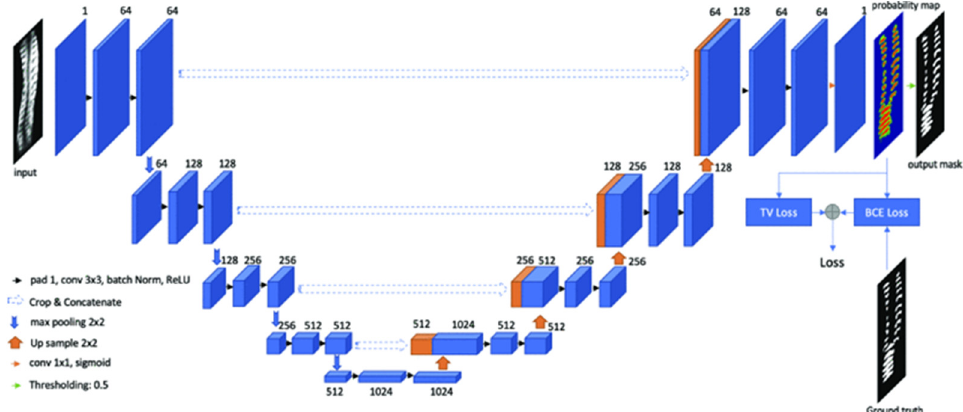
Figure 8. The architecture of RSN-U-net [97]: Similar to U-net, RSN-U-net is also composed of an encoder and decoder. The encoder section consists of four repeated encoder stacks. Each encoder stack contains two conv (3 × 3) convolutional layers and one max-pooling (2). Each decoder stack contains two conv (3 × 3) and one Upsampling (2).